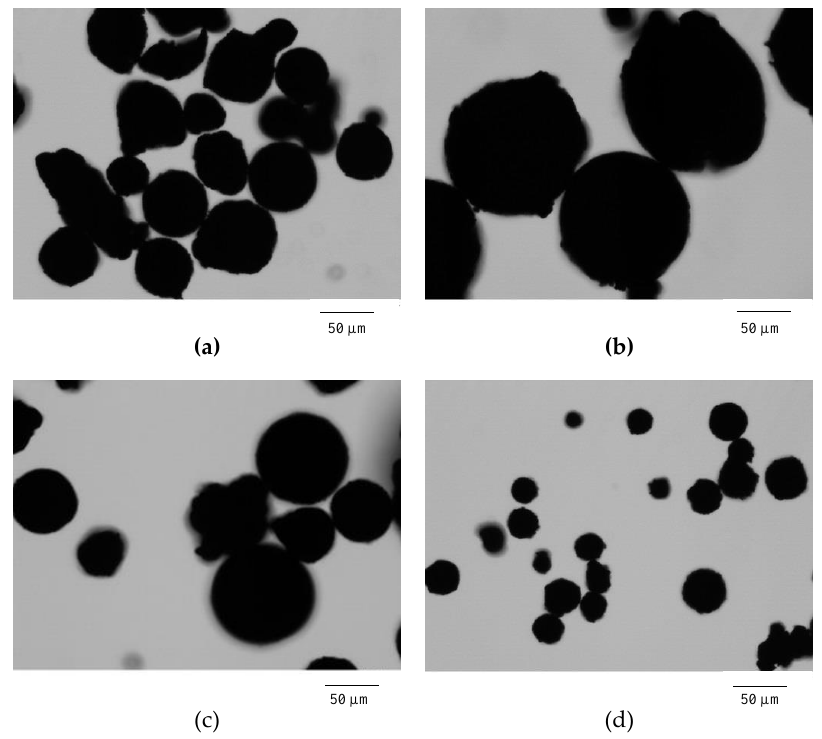
Figure 6. Morphology of carbonized microspheres. The scale bar is the same for all images. ( a ) EGDAM + St + 4L-C, ( b ) EGDMA + St + 4L-P1, ( c ) EGDMA + St + 4L-N, ( d ) EGDMA + St + 4L-Ag.